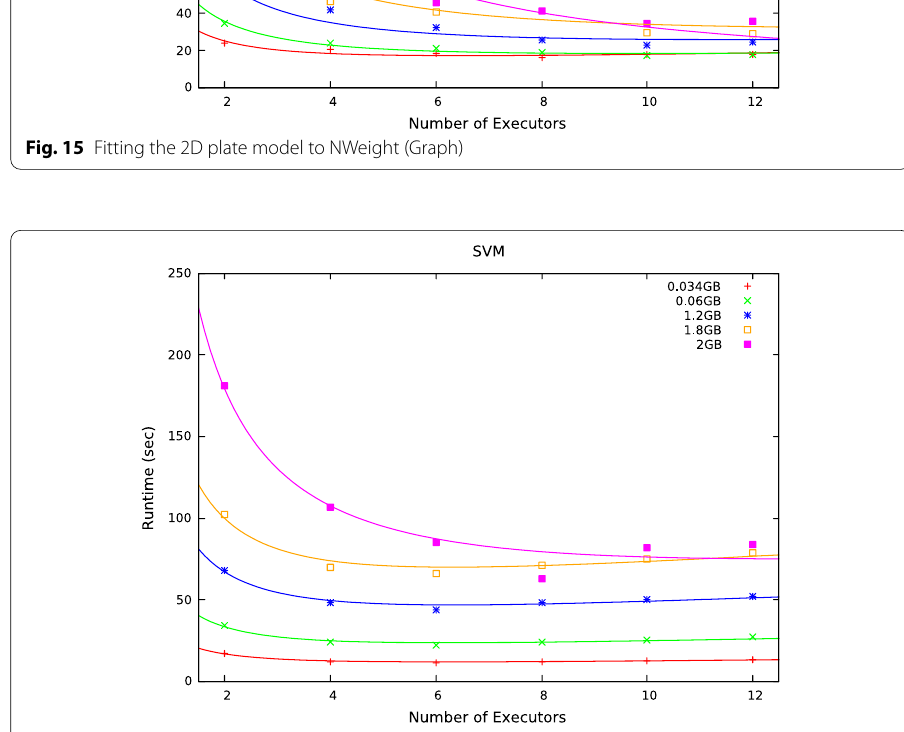
Fig. 16 Fitting the 2D plate model to